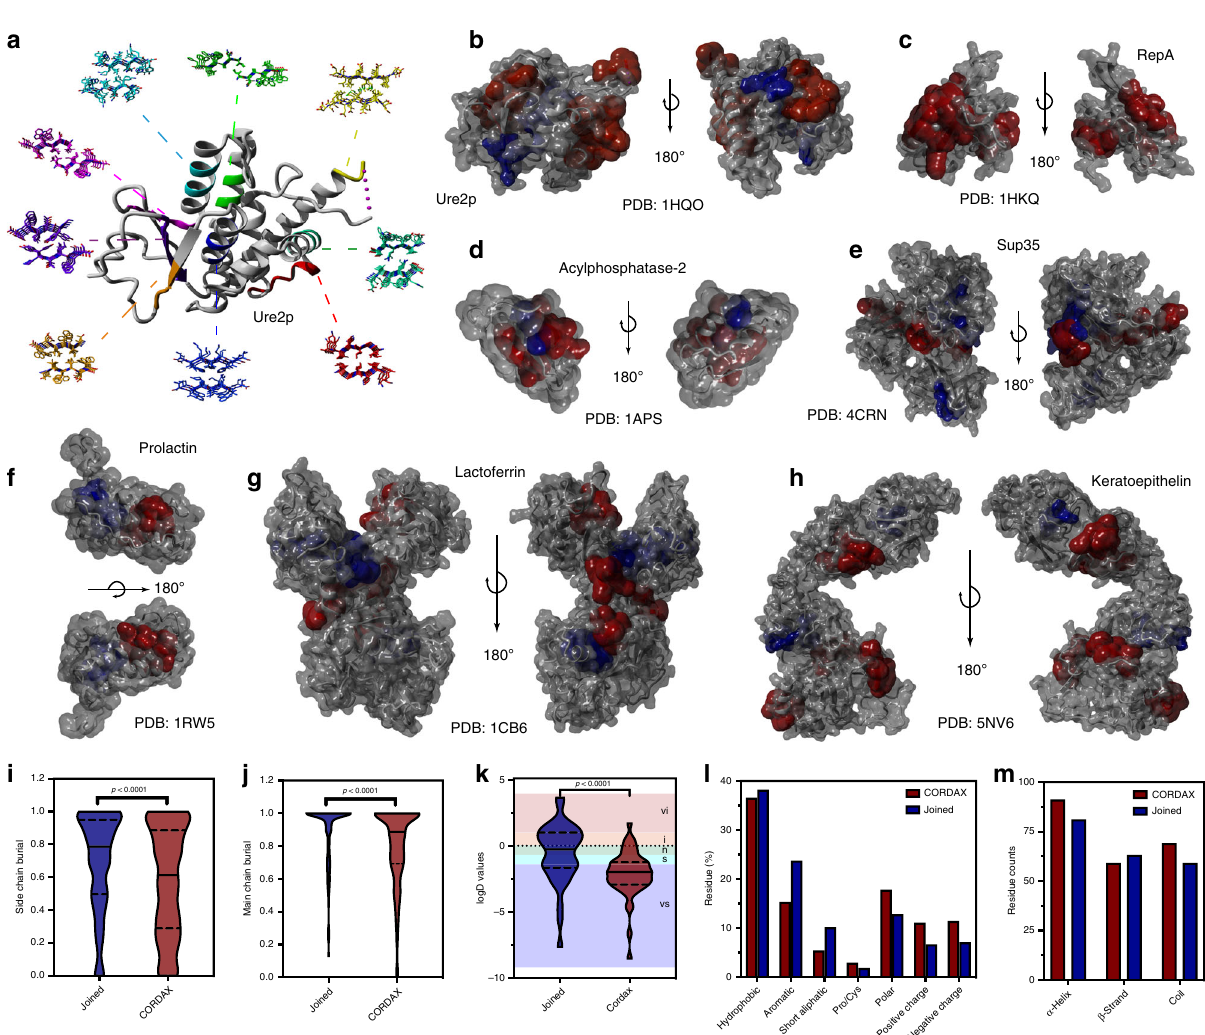
Fig. 5 Cordax identi fi es surface-exposed aggregation nucleators spanning residues that are typically considered unconventional for amyloid fi bril formation. a Schematic representation of Cordax-predicted topological models for APRs charted against the cognate native crystal structure of the amyloidogenic protein Ure2p. b – h Surface representation of folded structures for b Ure2p, c RepA, d Acylphosphatase-2, e Sup35, f Prolactin, g Lactoferrin and h Kerato-epithelin reveals that aggregation nucleators uniquely identi fi ed by Cordax (highlighted in red) are primarily exposed to the surface of proteins, compared to segments of joint prediction (shown in blue) which are predominantly buried within the hydrophobic core of the native fold. Cordax- speci fi c predicted APRs produced lower volumetric burial values, calculated using FoldX, for i side chain and j main chain groups indicating that they are considerably exposed compared to jointly identi fi ed nucleators. k Partition coef fi cients indicate that Cordax-speci fi c APRs are signi fi cantly more soluble compared to typically predicted sequences that are primarily hydrophobic and therefore insoluble. Solubility regions (vi very insoluble, i insoluble, n neutral, s soluble, vs very soluble) are shown as coloured backgrounds 72 . Signi fi cant differences were computed using one-way ANOVA with multiple comparison. l Surface-exposed Cordax-speci fi c APRs are composed of residues with a 20% increase in polar and charged side chains, in expense of hydrophobic residues ( n = 219 residues in APRs identi fi ed by Cordax, n = 203 residues in APRs from joined predictions). m Secondary structure analysis, using FoldX, indicates that Cordax identi fi es several APRs that reside in α -helical or unstructured regions within the native fold, suggesting that amyloidogenic proteins may harbour a plethora of exposed conformation switches that can act as potential nucleators of amyloid fi bril formation, under suitable misfolding conditions ( n = 219 residues in APRs identi fi ed by Cordax, n = 203 residues in APRs from joined predictions). Violin plots represent the kernel probability densities of the data with the median, upper and bottom quartiles. Source data are provided as a Source Data fi protein aggregation and have increased failure rates when iden- scope to improve the method, as in particular, the region with tifying such amyloid-forming stretches. On the other hand, high disorder propensity (cluster 11) still contains many false sequences with a high content of aromatic side chains are rela- negatives, in spite of the ability of Cordax to partially pick up a tively easy to identify (clusters 9a and 9b), following several lines minority of sequences. Interestingly, a closer look at the partition of evidence supporting their role in amyloid fi bril formation 48 . coef fi cients of the known amyloid sequence space reveals that Cordax also pushes forward into less well-charted areas of amy- although Cordax takes a signi fi cant step forward towards the loid sequence space, e.g. exploring clusters with high α -helical right direction, these APRs remain very hard to identify as they content (cluster 10) and overall a low content of aliphatic amino are characterised by even higher solubility values (Fig. 6i). Similar acids (clusters 5, 6, 7, 8 and 9b). These regions also reveal the charting of the amyloid sequence space is achieved by using